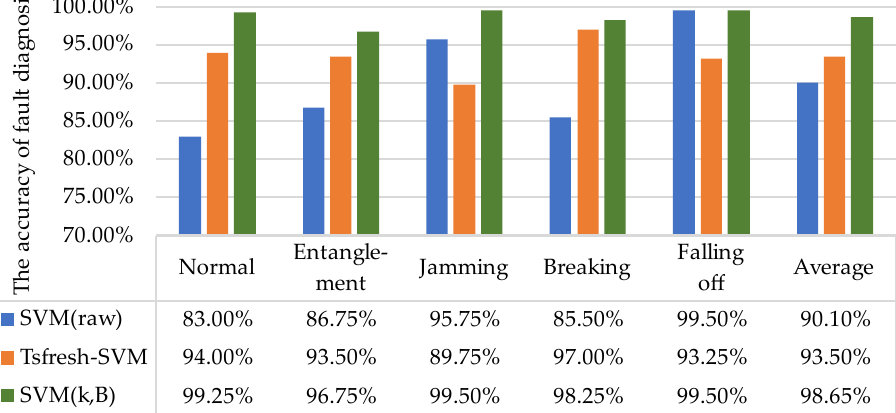
Figure 9. Comparative experiments of the thruster fault diagnosis